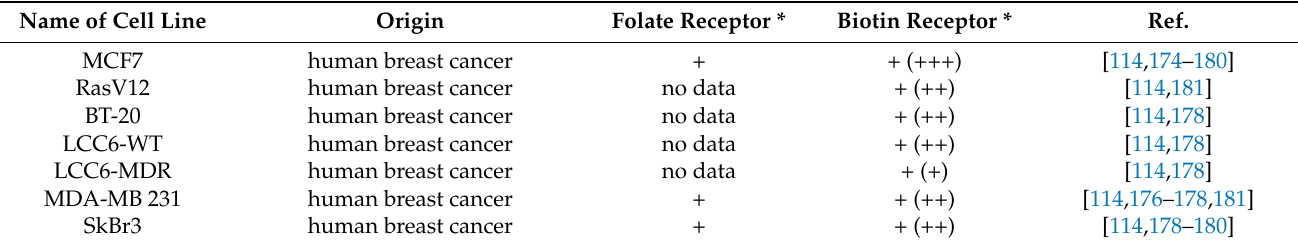
Table 7. Various cell lines with positive or negative biotin receptor